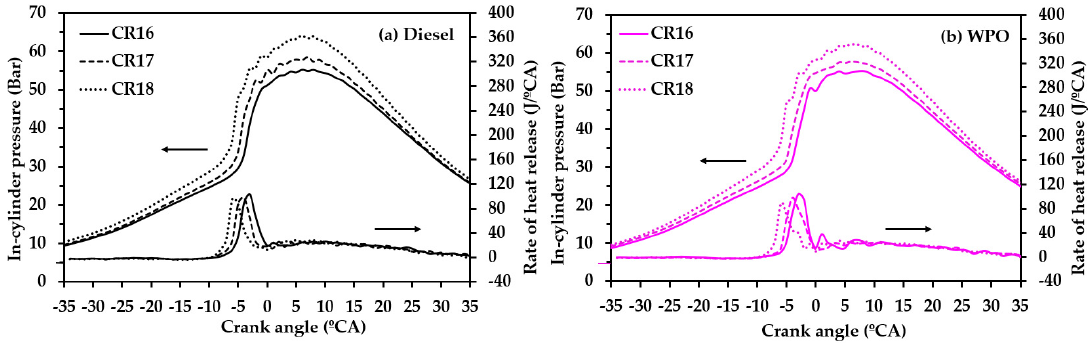
Figure 7. Variation in the rate of heat release (RoHR) and in-cylinder pressure (ICP) with the crank angle at different compression ratios at a 75% maximum engine torque: ( a ) diesel; ( b ) WPO.